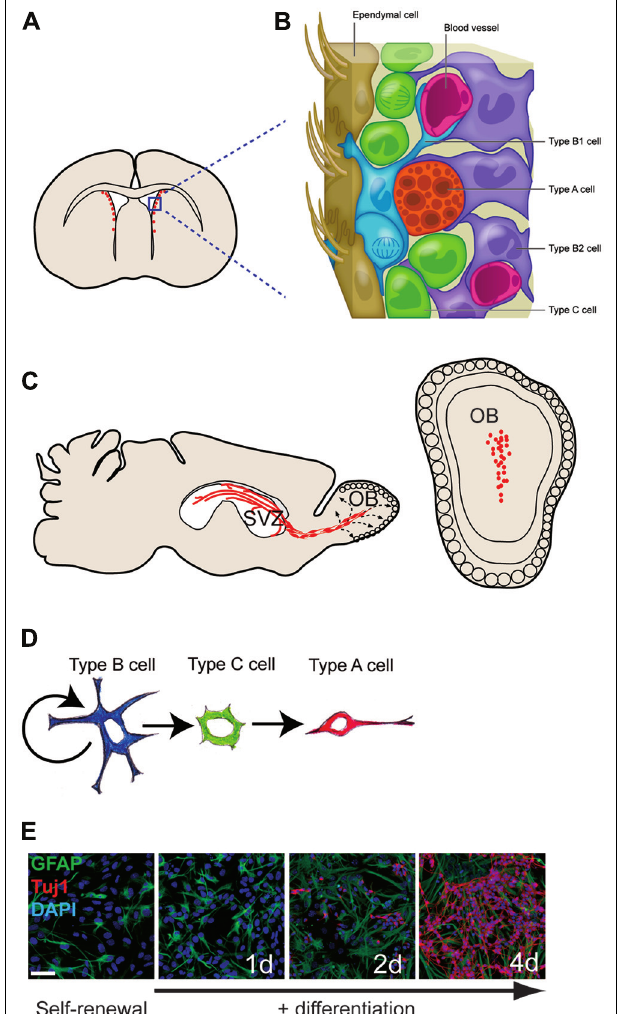
FIGURE 1 |The adult mouse SVZ: a tractable system for molecular- genetic studies of NSC differentiation. (A) Coronal view of SVZ. (B) Enlarged view of SVZ: type B cells (blue) can contact the ventricle with a thin process extended between ependymal cells (brown); type C cells (green) are transit-amplifying cells that give rise to migratory type A cells (red). (C) Sagittal view showing paths of migratory neuroblasts (red, type A cells) to the OB. (D) The neuronal lineage of self-renewing type B cells. (E) SVZ NSC culture in self-renewal (left) and differentiation (right) conditions.The astrocyte marker GFAP in green, the neuronal markerTuj1 in red, and DAPI in